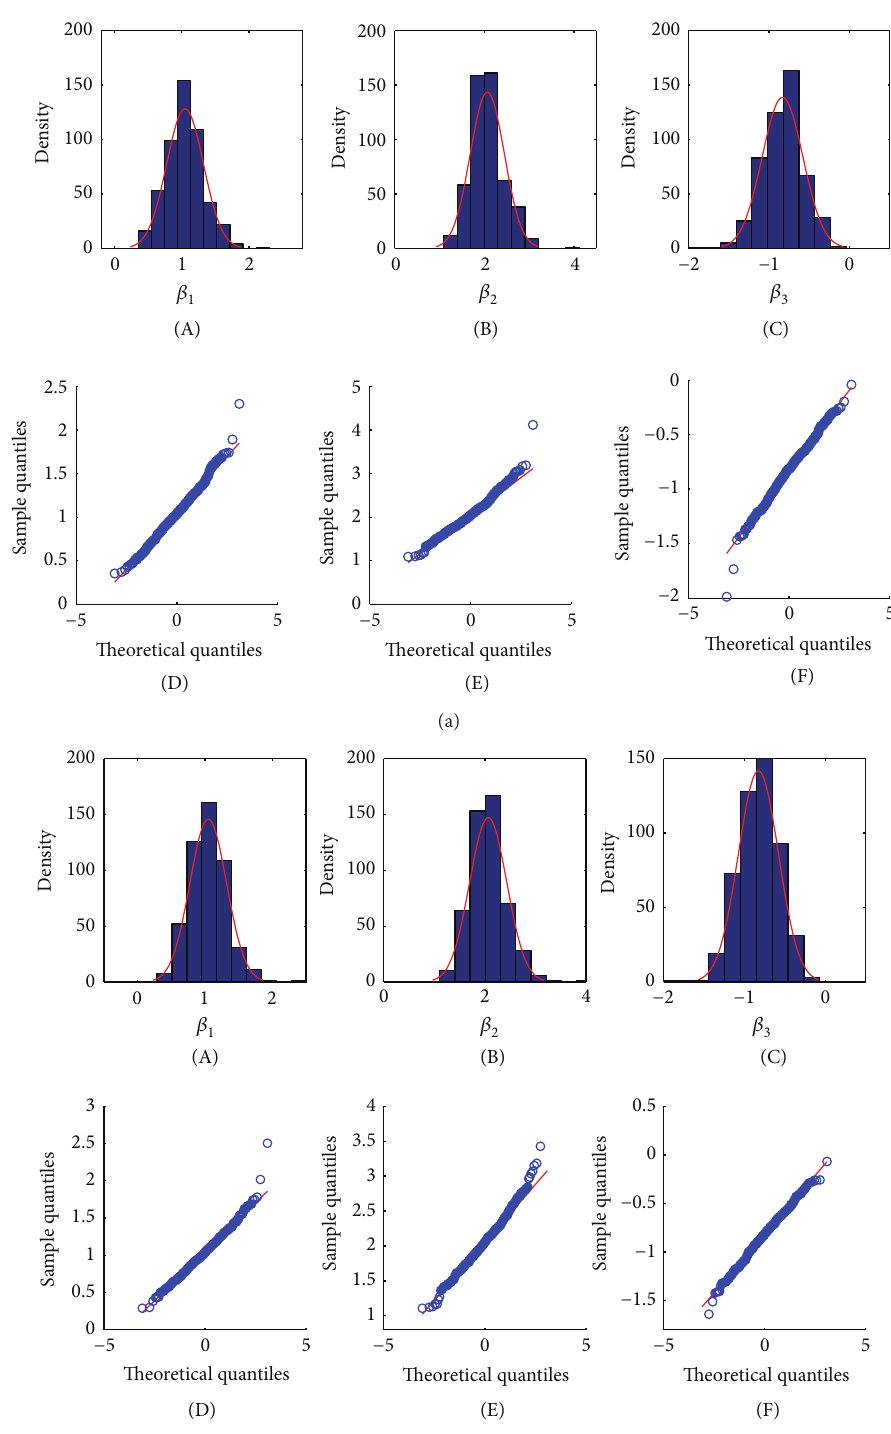
Figure 1: The histograms and the QQ plots for the maximum empirical likelihood estimators based on the empirical likelihood method for 𝑛 = 60 . When the true correlation structure is AR(1), the left plots are obtained by using the misspecified CS working correlation structure and the right plots are obtained by using the true AR(1) working correlation